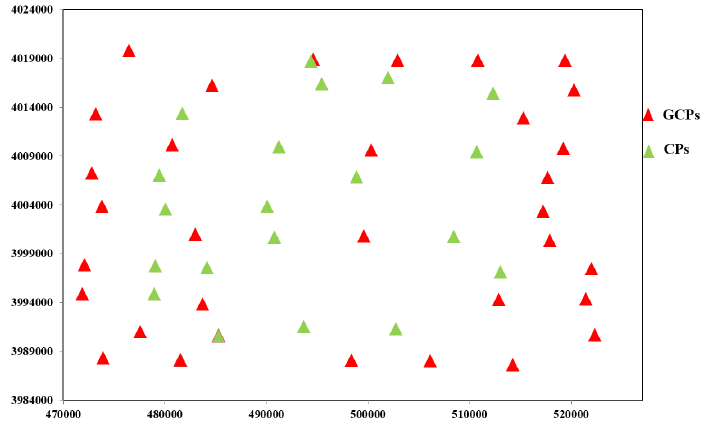
Figure 7. Distribution of the GCPs and CPs for the Taian